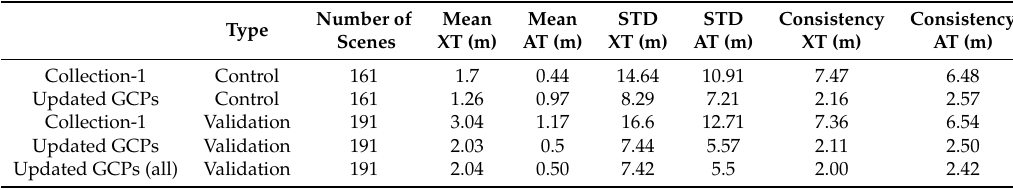
Table 9. Validation of the GCP updates using the geodetic accuracy validation procedure for the Americas block.